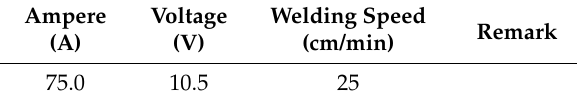
Table 4. Results of X ‐ ray inspection, quantity, and size of pores ( d ).